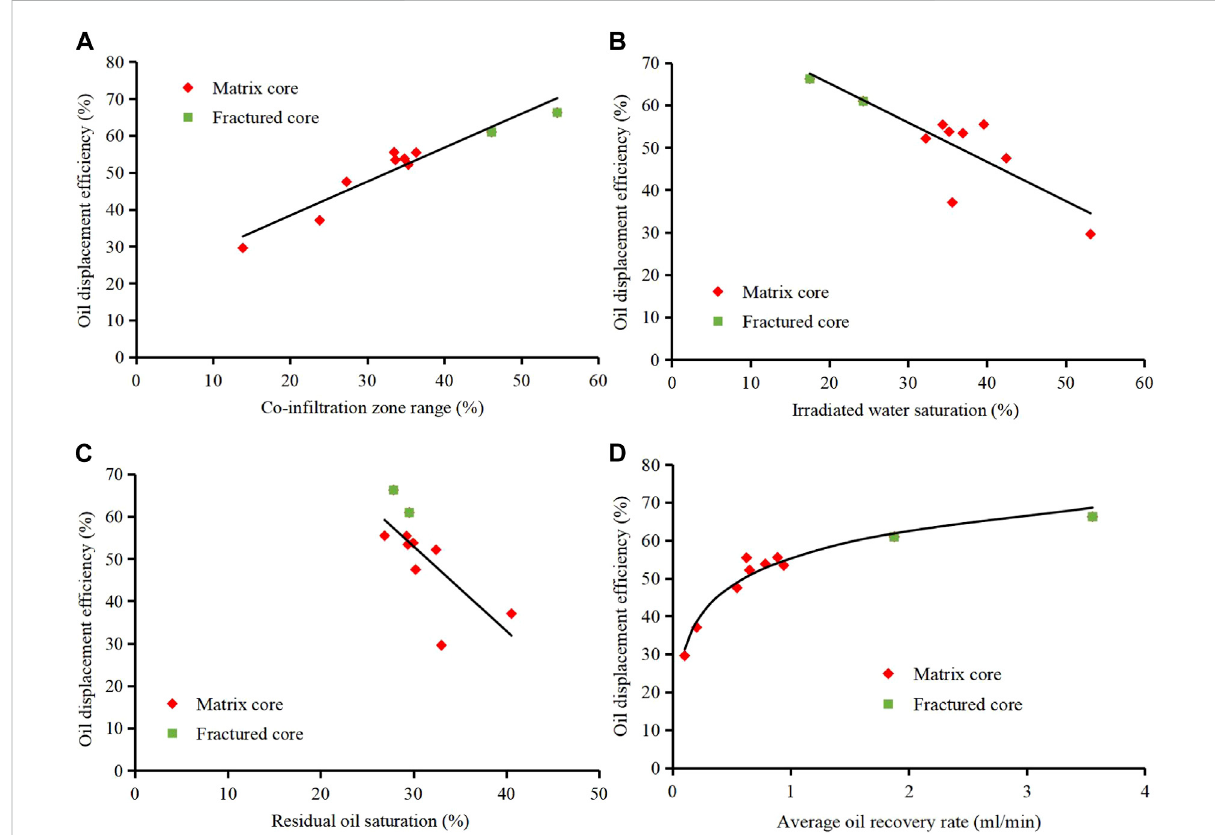
FIGURE 11 Water fl ooding characteristics of the target layer. Notes: (A) Relationship between oil displacement ef fi ciency and co-permeability zone range; (B) Relationship between oil displacement ef fi ciency and irreducible water saturation; (C) Relationship between oil displacement ef fi ciency and residual oil saturation; (D) Relationship between oil displacement ef fi ciency and average oil recovery